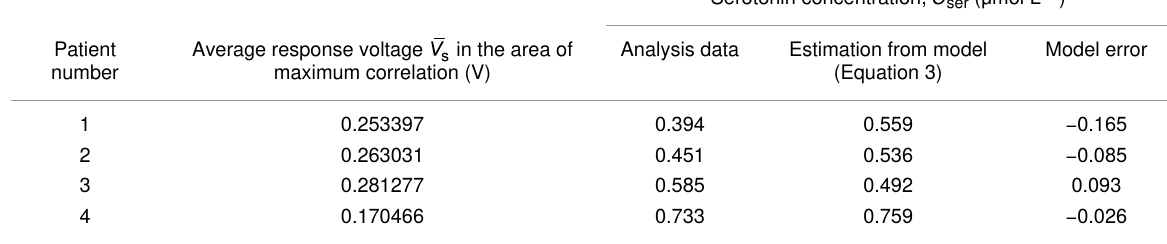
Table 1: Verification of the sensor model for the determination of serotonin concentration.